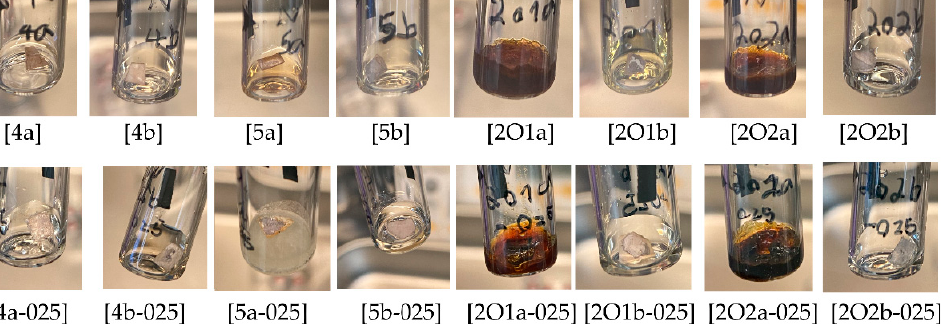
Figure 3. Images of the stored electrolytes (28 d) over sodium metal at 25 °C. a = [TFSI] ‐ , b = [FSI] ‐ .